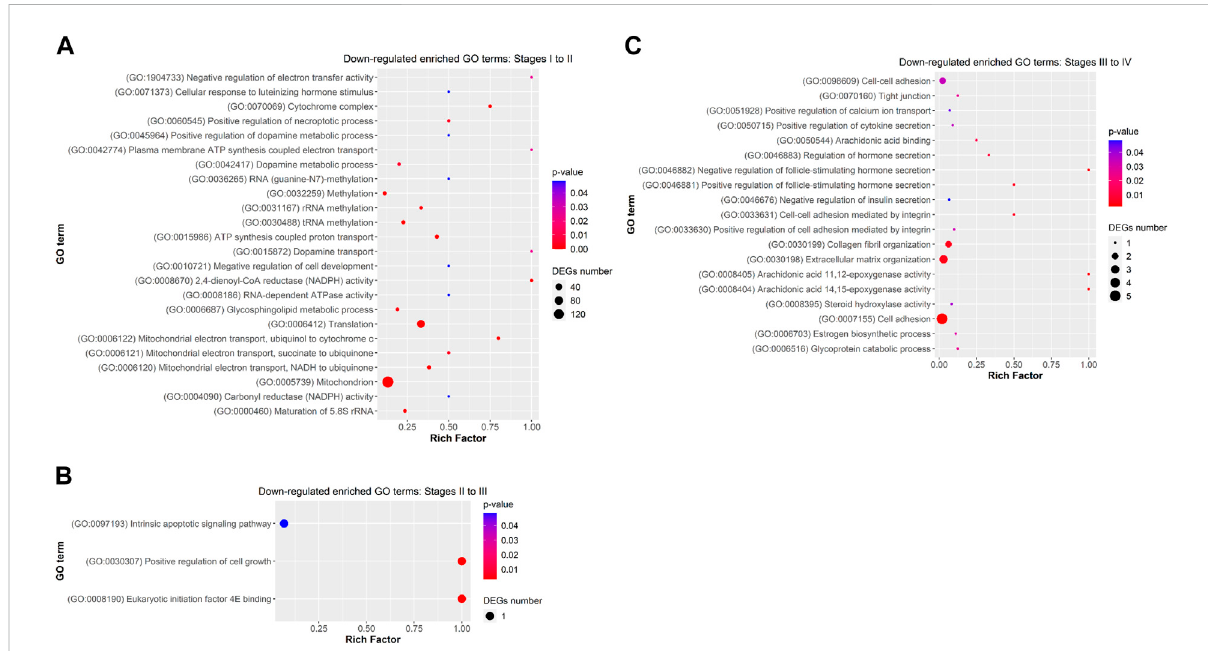
FIGURE 6 Dotplotshowingsomerelevantsigni fi cantlyenrichedGeneOntologybiologicalprocesses,cellularcomponentsandmolecularfunctionsfrom downregulatedDEGsin (A) StageItoII (B) StageIItoIII,and (C) StageIIItoIV.Richfactoristheratioofthedifferentiallyexpressedgenenumbertothe total gene number in a certain GO term. The colour and size of the dots represent the range of the p -value and the number of DEGs mapped to the indicated GO term,